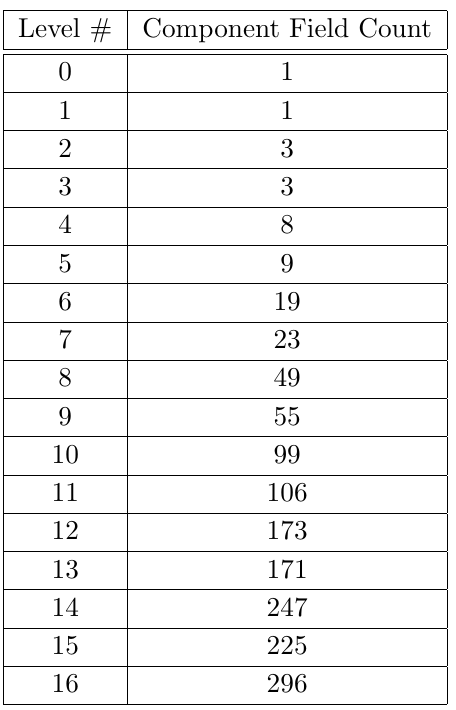
Table 5. Number of Independent Fields at Each